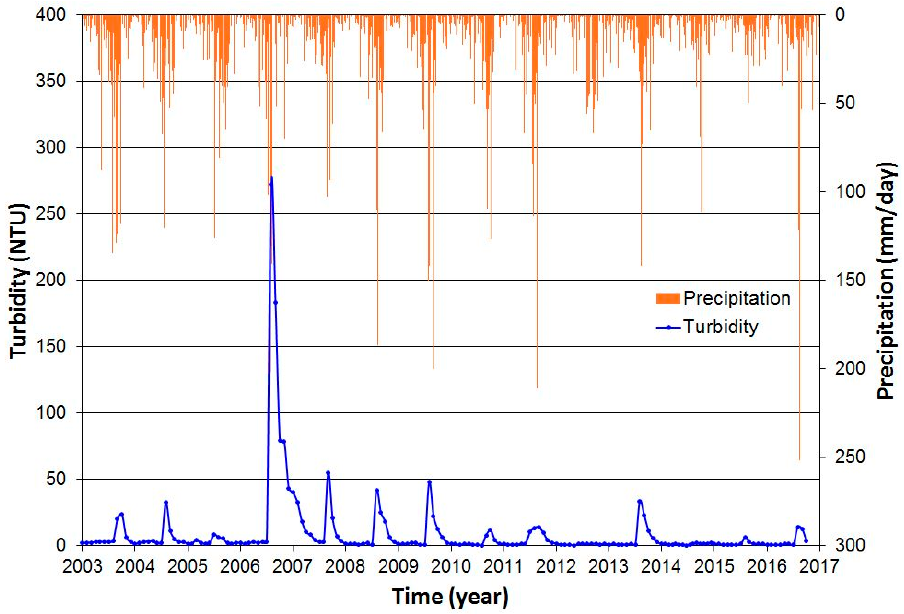
Figure 13. Turbidity variation of the Lake Soyang Dam effluent.